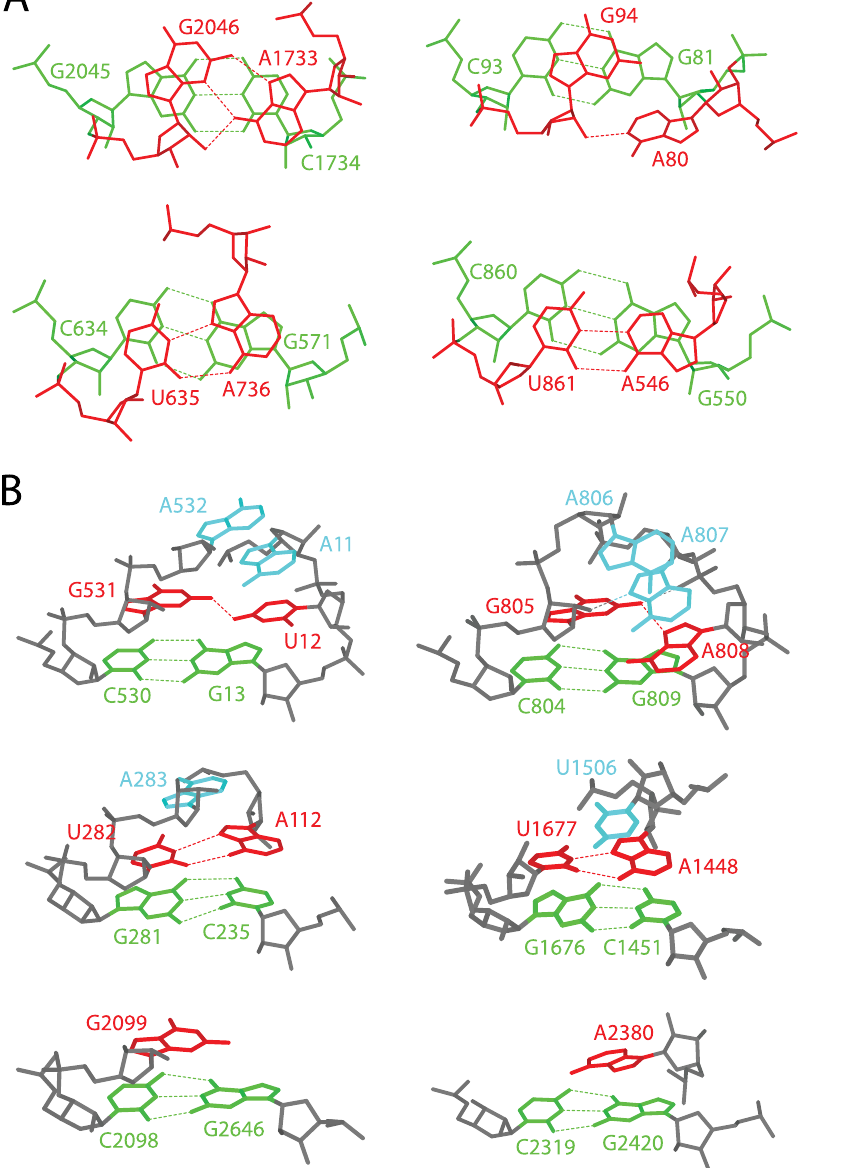
Figure 3. Representative helix capping motifs in rRNAs and their topological protection of helix ends against fraying. ( A ) Stacking patterns of capping basepair motifs over helix ends: G:A C-caps (upper panels) in the sheared (G2046:A1733 in H23S, left) and reversed sheared (G94:A80 in H23S, right) conformation; U:A D-caps (lower panels) in the reversed Hoogsteen (U635:A736 in T16S, left) and reversed Watson-Crick (U861:A546 in T16S, right) conformation. ( B ) Helix capping motifs further associated with forming hairpin-like loop folds over helix ends: A C-cap in a multistem loop, U12:G531 in H23S (top left), is further involved in forming a structure similar to the GNRA tetraloop (top right); D-caps in multistem loops, A112:U282 in T16S and A1448:U1677 in H23S, are further involved in forming an overall hairpin-like loop fold (middle panels); Unpaired capping nucleotides, G2099 C 9 -cap and A2380 D 9 -cap in H23S, form a hairpin-like structure by themselves (bottom panels). As in Figure 1, while helix ends are shown in green and helix capping motifs in red, the nucleotides further associated from the loop side are shown in cyan.